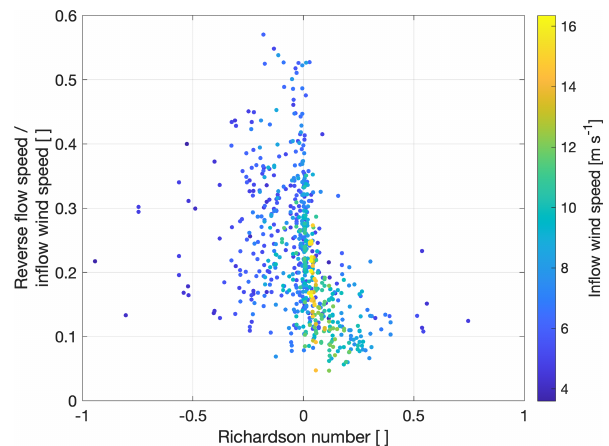
Figure 9. Observational periods with recirculation (colored mark- ers) and without recirculation (grey cross marks) under stratified conditions as a function of mean lee-side slope ( h/A ) and Nh/u . The round markers refer to recirculation at the southwest ridge and the square markers to northeast ridge. The colored diamond mark- ers show the mean value of Nh/u per transect during periods with recirculation and the grey markers the mean for periods without re- circulation. The solid black line shows where NA/u = π .